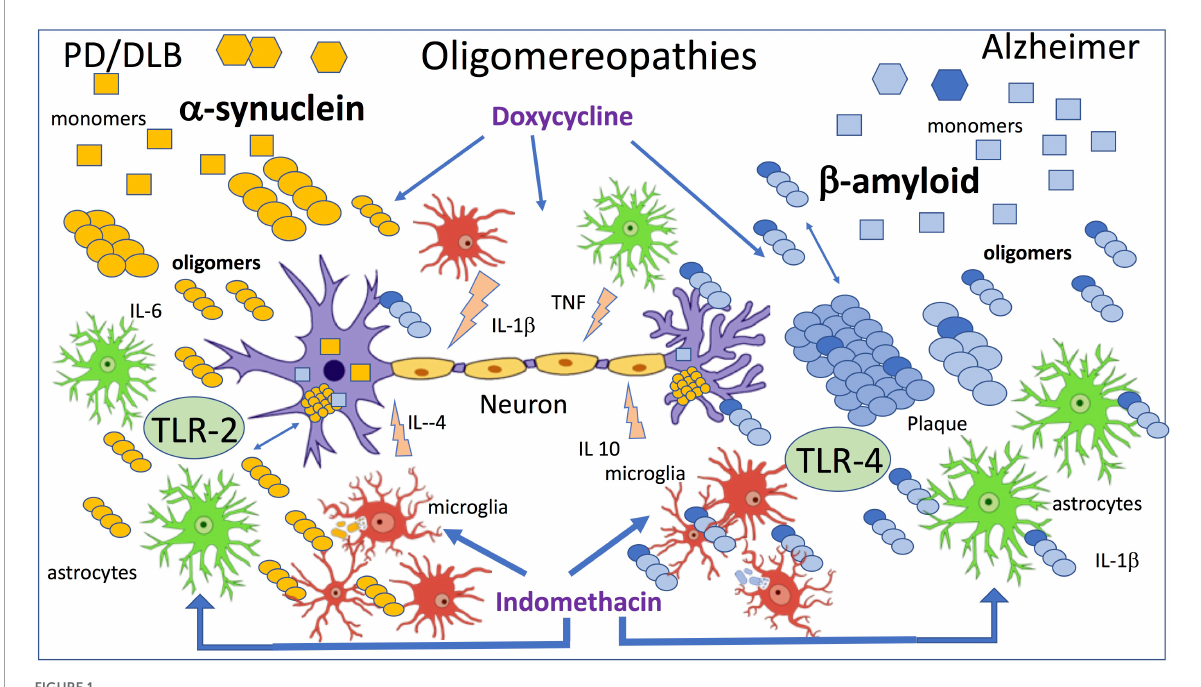
FIGURE1 The figure summarizes the effects of β amyloid and α -synuclein oligomers directly applied by intracerebral injection. Wild-type mice were injected ICV with 7.5 µ l of 1 µ M oligomers, and indomethacin and doxycycline were injected peripherally 2 h before oligomers injection (Forloni et al., 2016; Balducci et al., 2018; La Vitola et al., 2018,